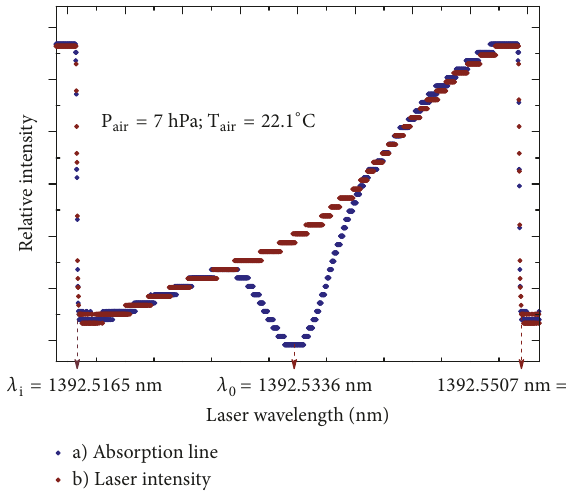
Figure 1: Overview of water vaporlines emission around 7181 cm −1 . ( ∗ ): from HITRAN database. Figure 2: Transmitted intensities I t and I 0 as a function of the laser wavelength around 1392.53 nm. (a) I t ( 𝜆 ) and (b) I 0 ( 𝜆 ).